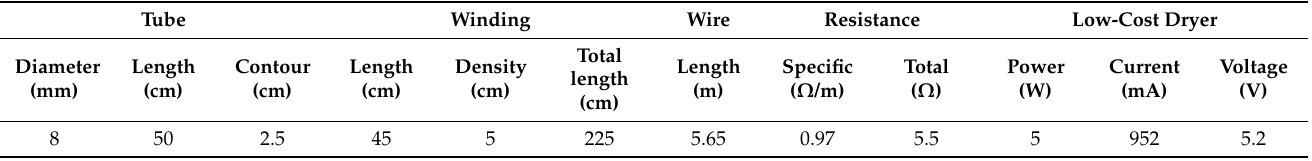
Figure 5. Schematic diagram of the low-cost dryer. Table 1. Calculations for the low-cost